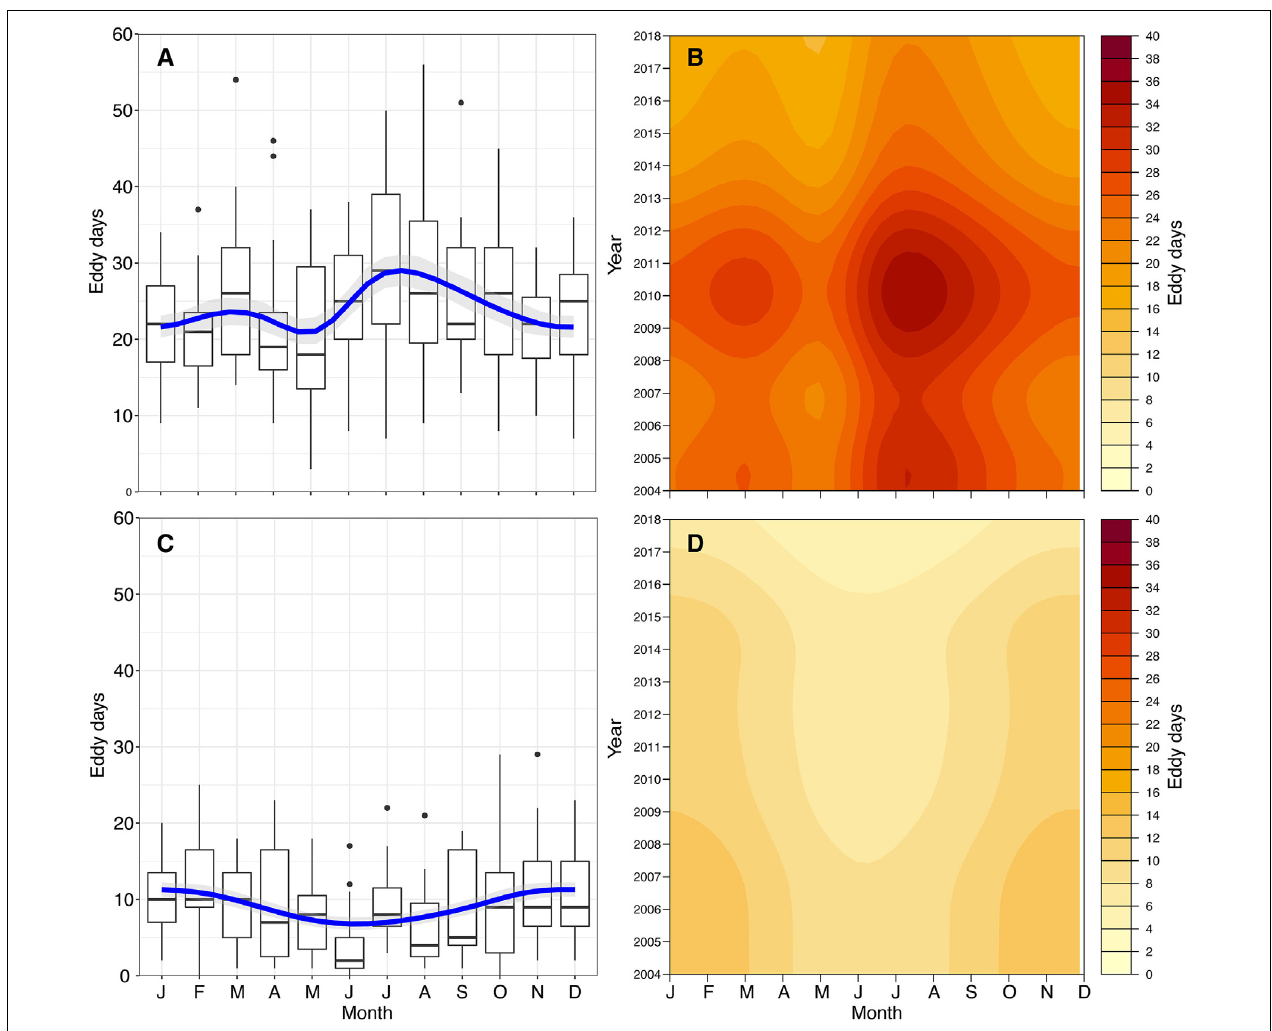
FIGURE 2 | Interactions of mesoscale features with the FGB. Interactions are described as Eddy Days, and shown by eddy spin direction (cyclonic, A,B ; anticyclonic, C,D ). Monthly summaries are shown in boxplots (A,C) with Poisson GAM predictions with cyclic cubic regression splines. GAM predictions across year and month are shown as heat maps (B,D) to demonstrate broad trends in the physical environment of the